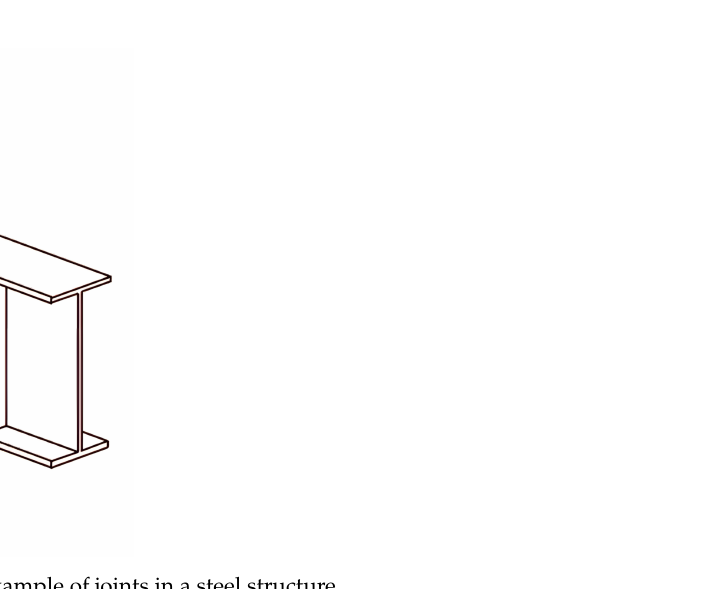
Figure 1. Illustrative example of joints in a steel